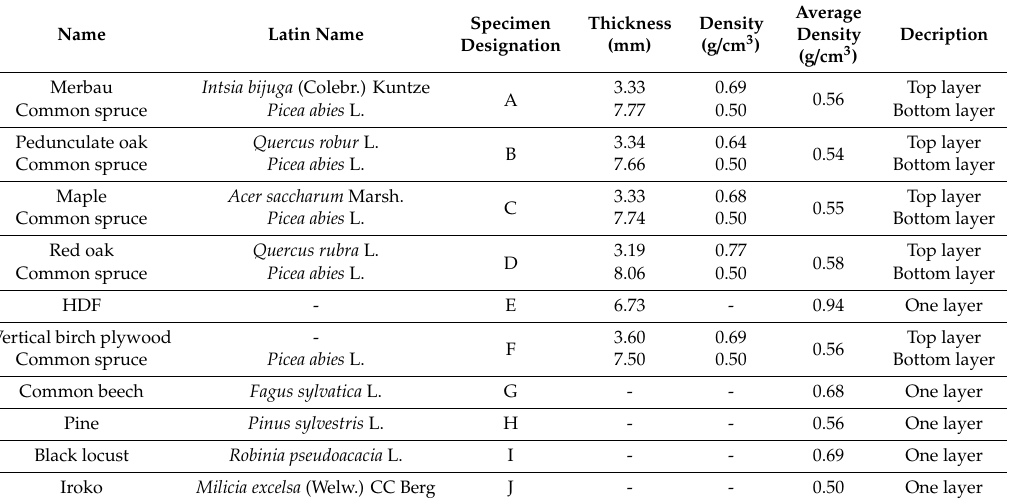
Table 1. Characteristics of test